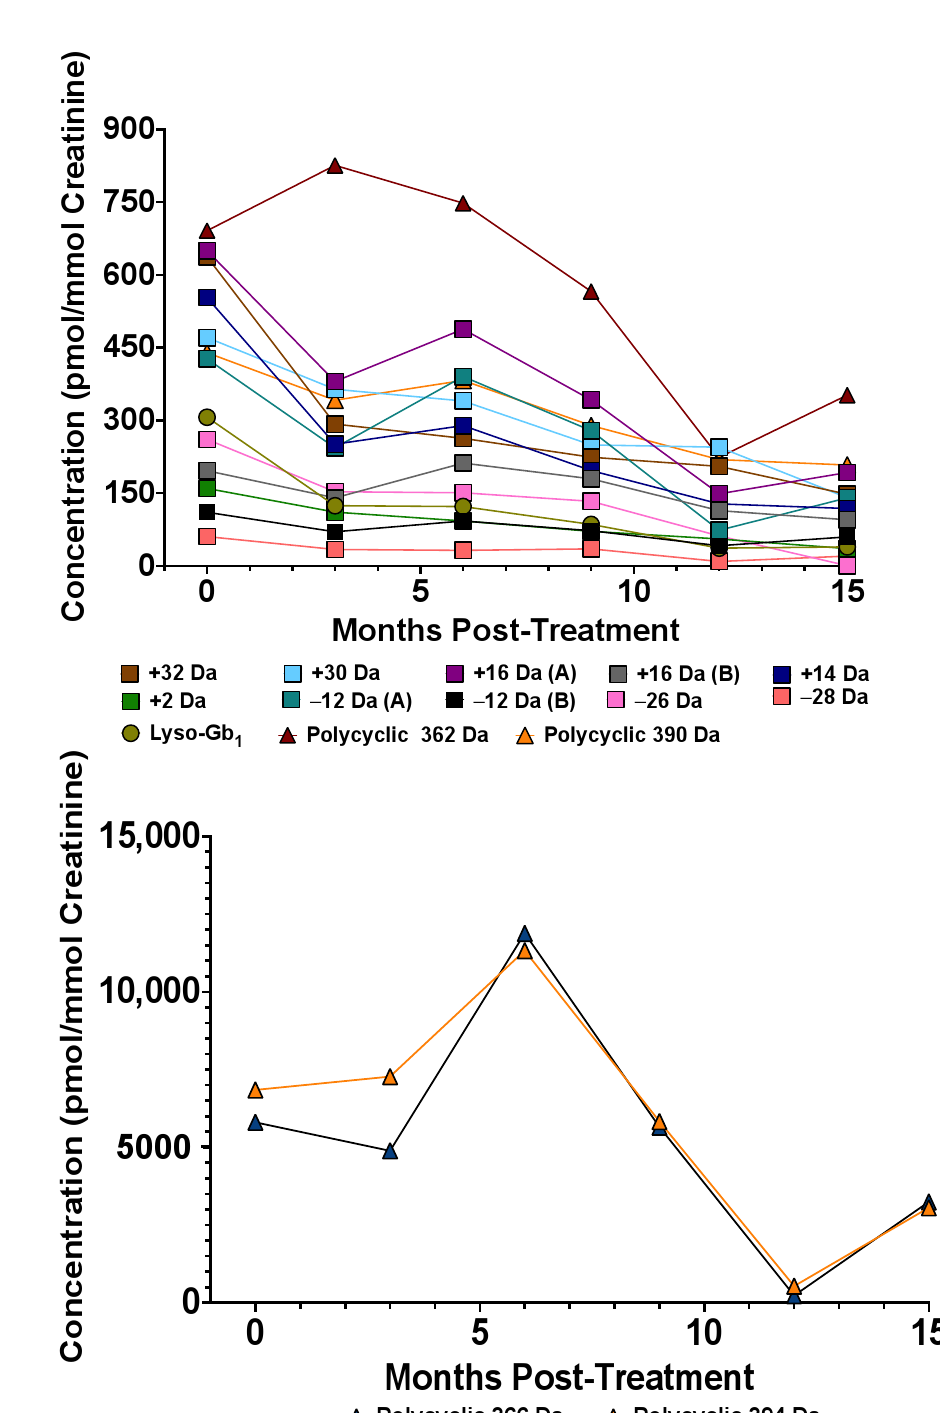
Figure 8. Biomarker concentration levels post-ERT treatment in a 55-year-old female GD type 1 patient with p.N370S/D409H mutations: ( A ) Concentration variation levels post-ERT for lyso-Gb 1 , lyso-Gb 1 analogs +32, +30, +16 (A), +16 (B), +14, +2, − 12 (A) and (B), − 26, and − 28 Da, as well as polycyclic analogs 390 and 362 Da; ( B ) Concentration variation levels post-ERT for polycyclic lyso-Gb 1 394 and 366 Da.